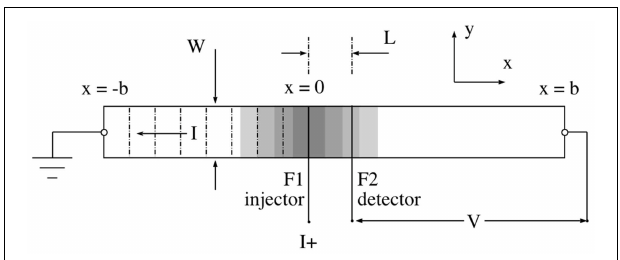
FIGURE 1 | Geometry of the nonlocal lateral spin valve (NLSV), top